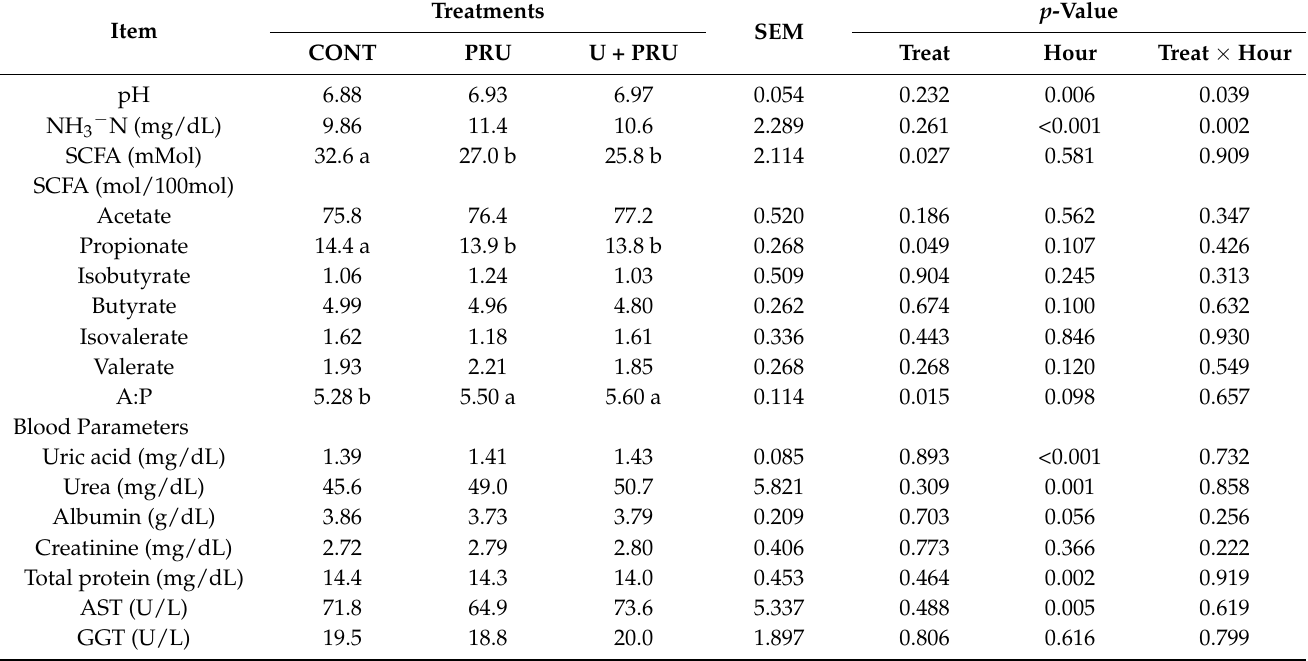
Table 4. Ruminal fermentation and blood parameters at different times after supplementation in Nellore steers supplemented with post-ruminal urea and conventional urea during the dry